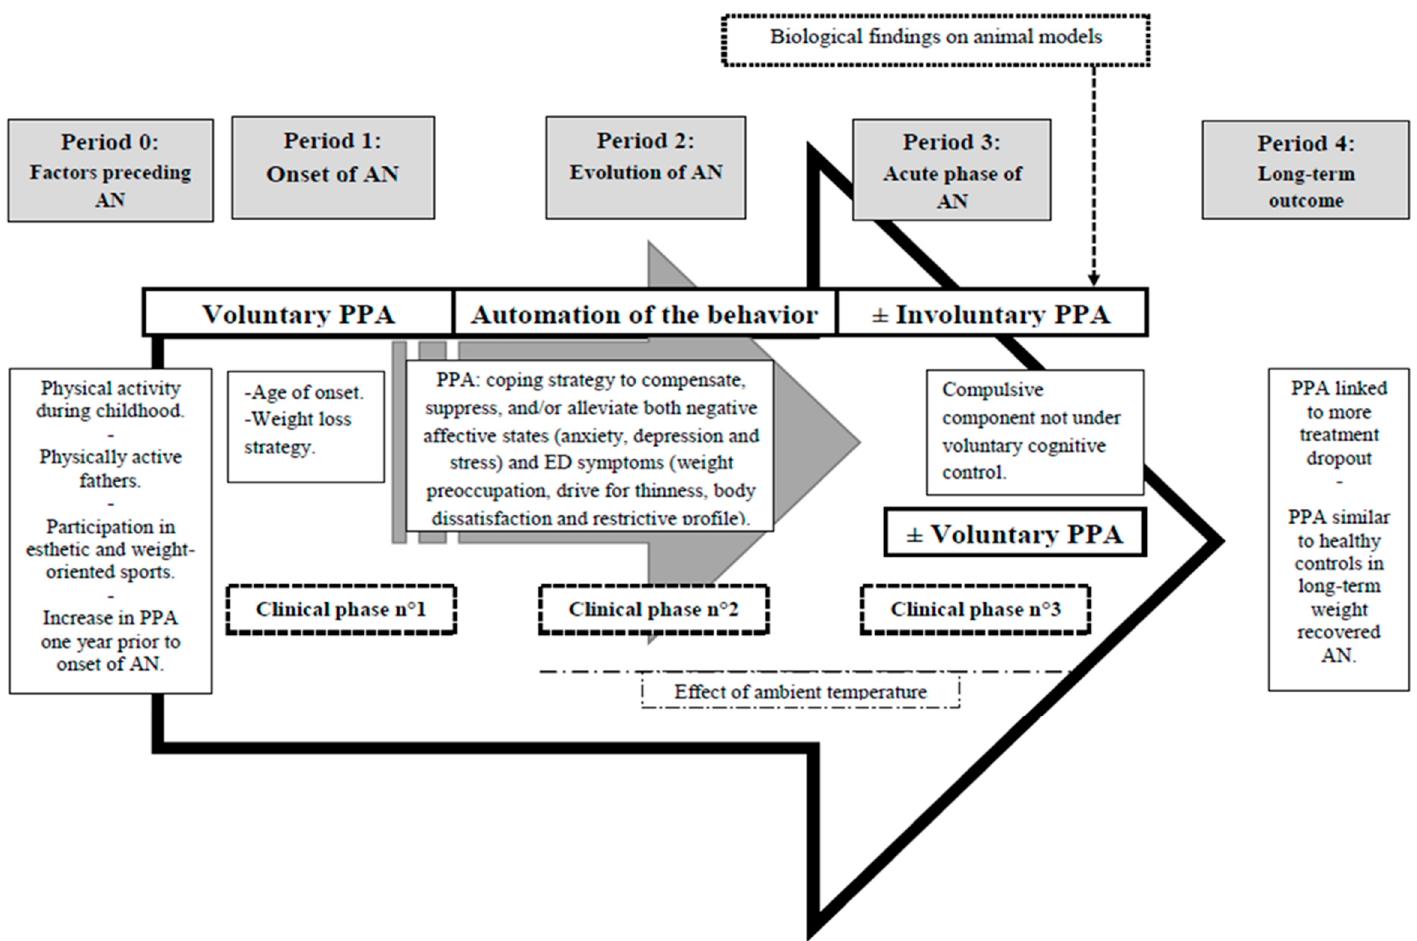
Figure 2. Proposed comprehensive model of development of problematic use of physical activity (PPA) in AN.